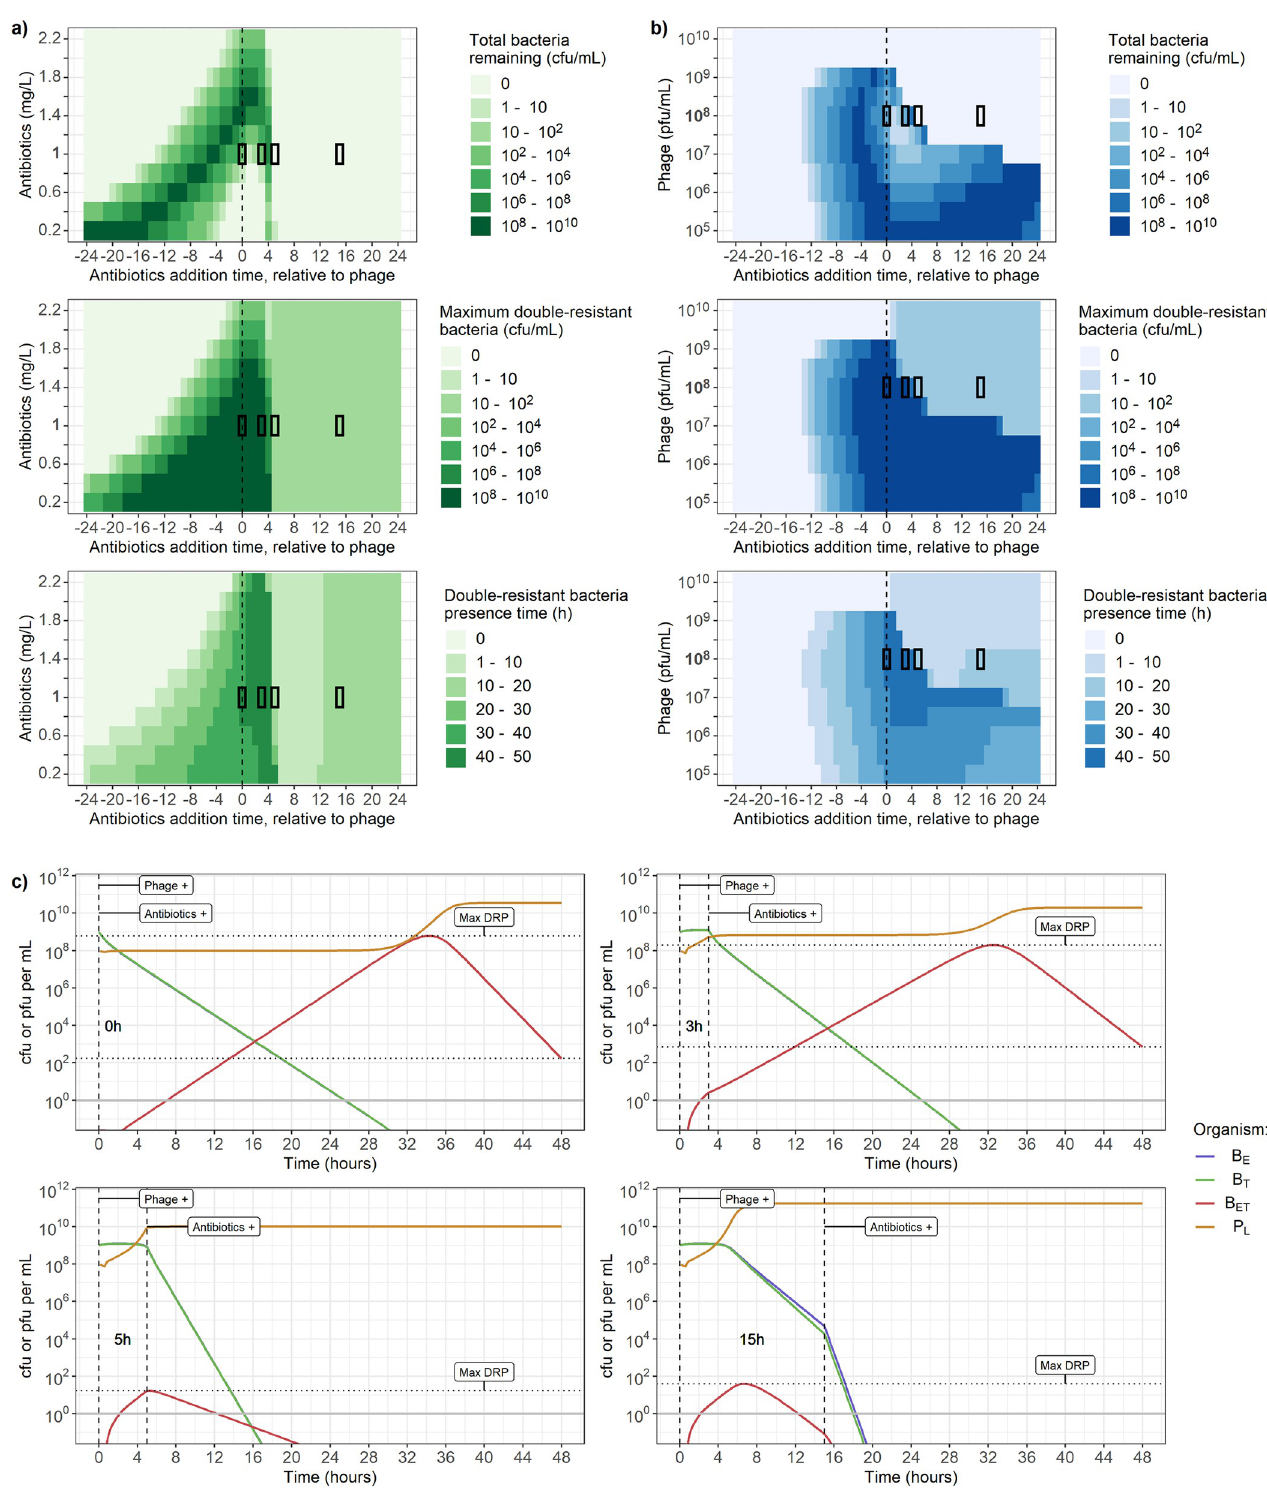
Fig 5. a-b) Varying timing (x-axis) and dose of antibiotic and phage (y-axis) affects total bacterial count after 48h (top), maximum concentration of double-resistant bacteria (B ET ) (middle), and time when the concentration of B ET is greater than 1 colony-forming unit (cfu) per mL (bottom). a) Adding 10 8 plaque-forming units (pfu) per mL of phage, and between 0.2 and 2.2 mg/L of both erythromycin and tetracycline. b) Adding 1 mg/L of both erythromycin and tetracycline, and between 10 5 and 10 10 pfu/mL of phage. The x-axis indicates the time when antibiotics were added, relative to when phage were added. For